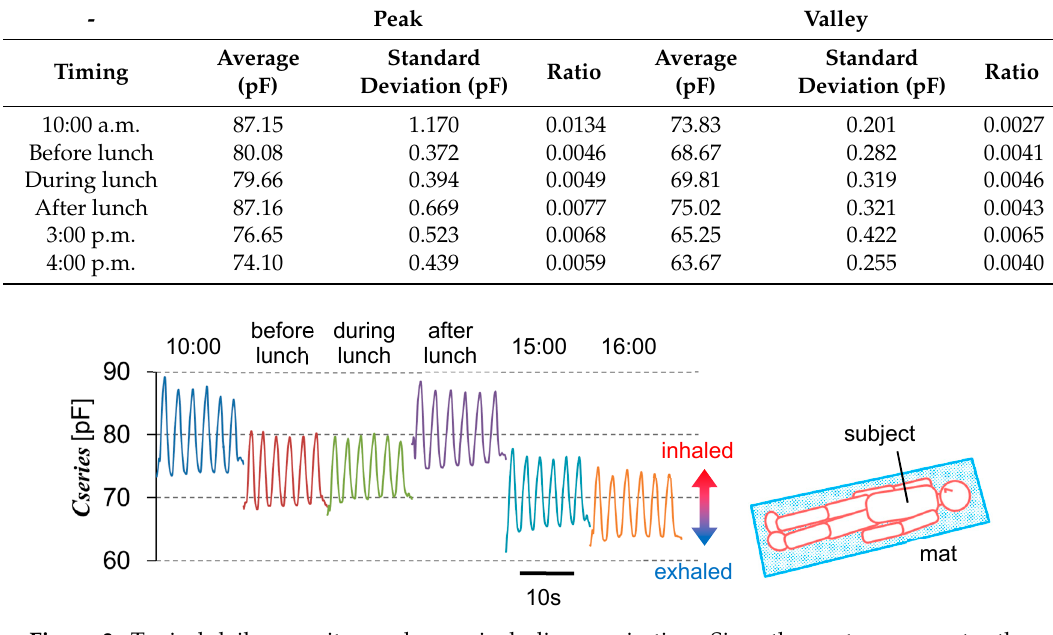
Figure 3. Typical daily capacitance change, including respiration. Since the posture generates the capacitance change, it is stabilized by lying on a mat.